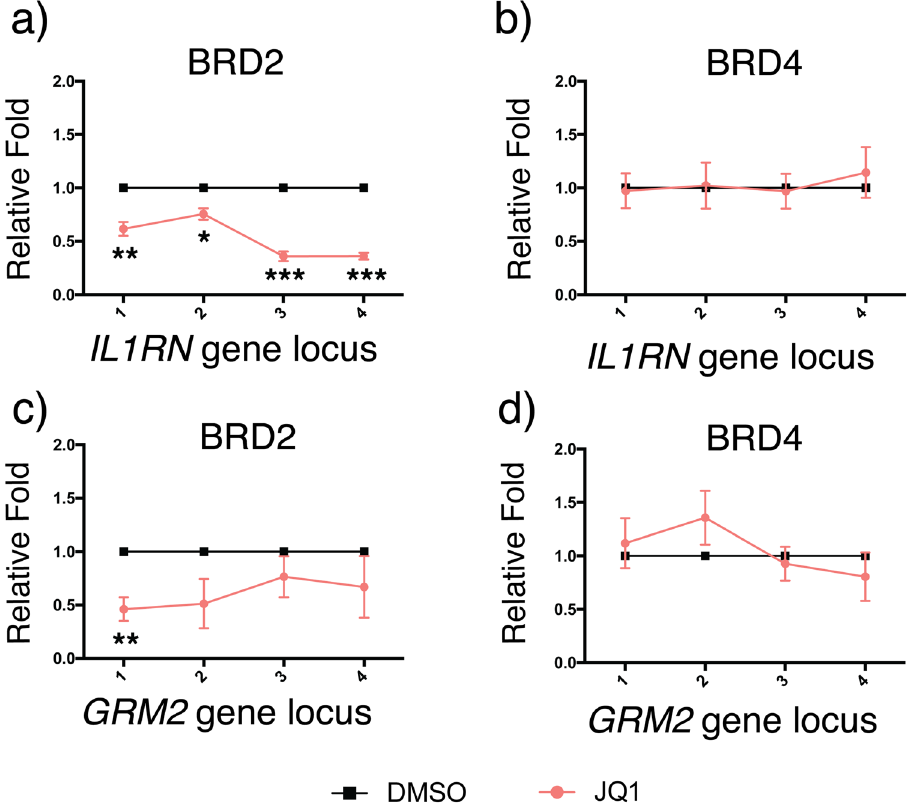
Figure 6. The effects of JQ1 on BRD recruitment upon dCas9-p300 targeting. Enrichment of BRD2 at ( a ) IL1RN and ( c ) GRM2 loci upon JQ1 treatment under dCas9-p300 targeting. Enrichment of BRD4 at ( b ) IL1RN and ( d ) GRM2 loci upon JQ1 treatment under dCas9-p300 targeting. Fold changes of BRD2 and BRD4 enrichment were calculated by normalizing results to those from DMSO-treated samples. Error bars represent ± s.e.m. from biological replicates (n = 3 for a ; n = 5 for b , d ; n = 4 for c ). The p value less than 0.05 was marked as *, less than 0.01 as ** and less than 0.001 as